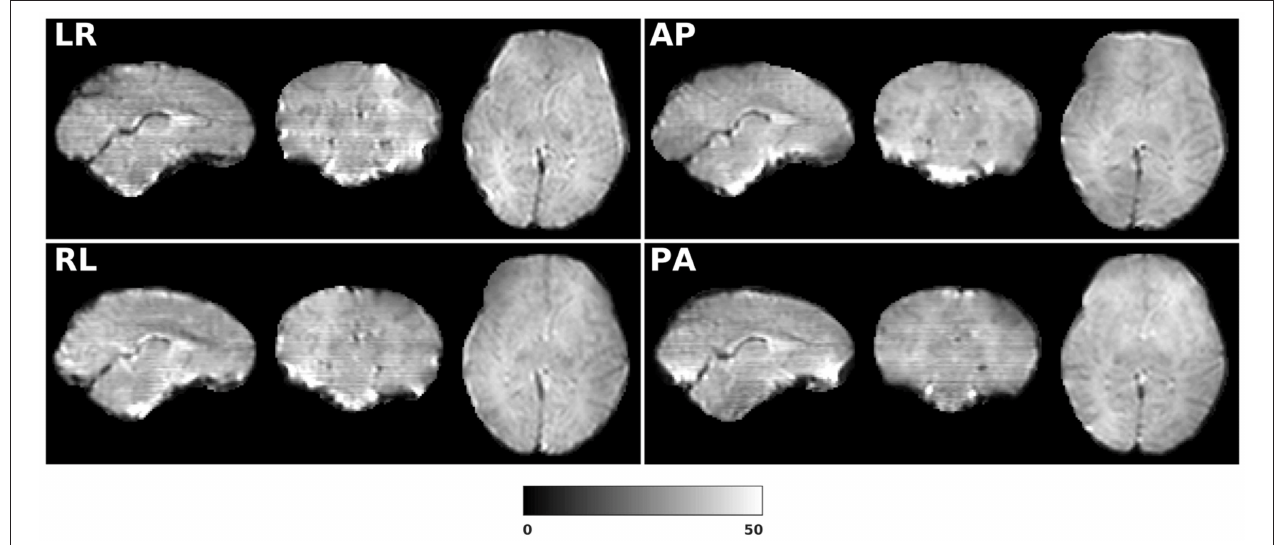
FIGURE 14 | LRRL and APPA pairs for dHCP Subject CC00069XX12.